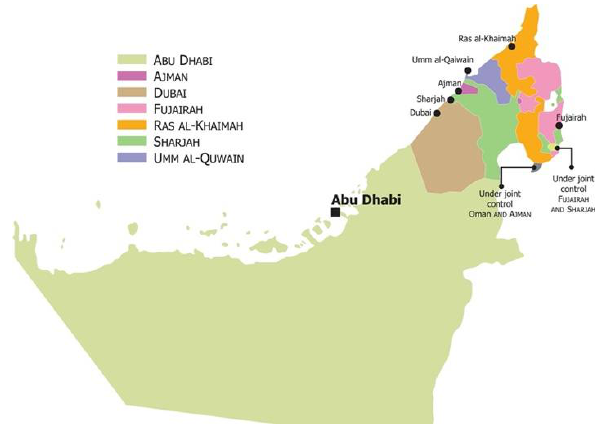
Figure 2. Map of the seven states of the United Arab Emirates. Used with permission from Pngegg.com accessed on 1 June 2021.